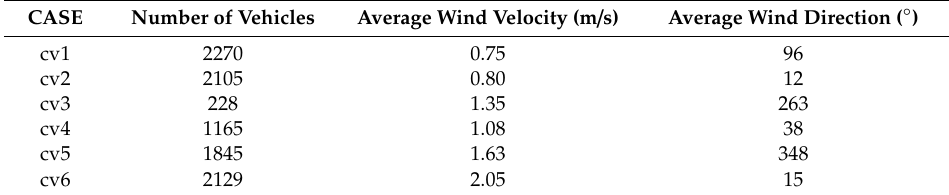
Table 2. Validation cases (CV) used in the study.